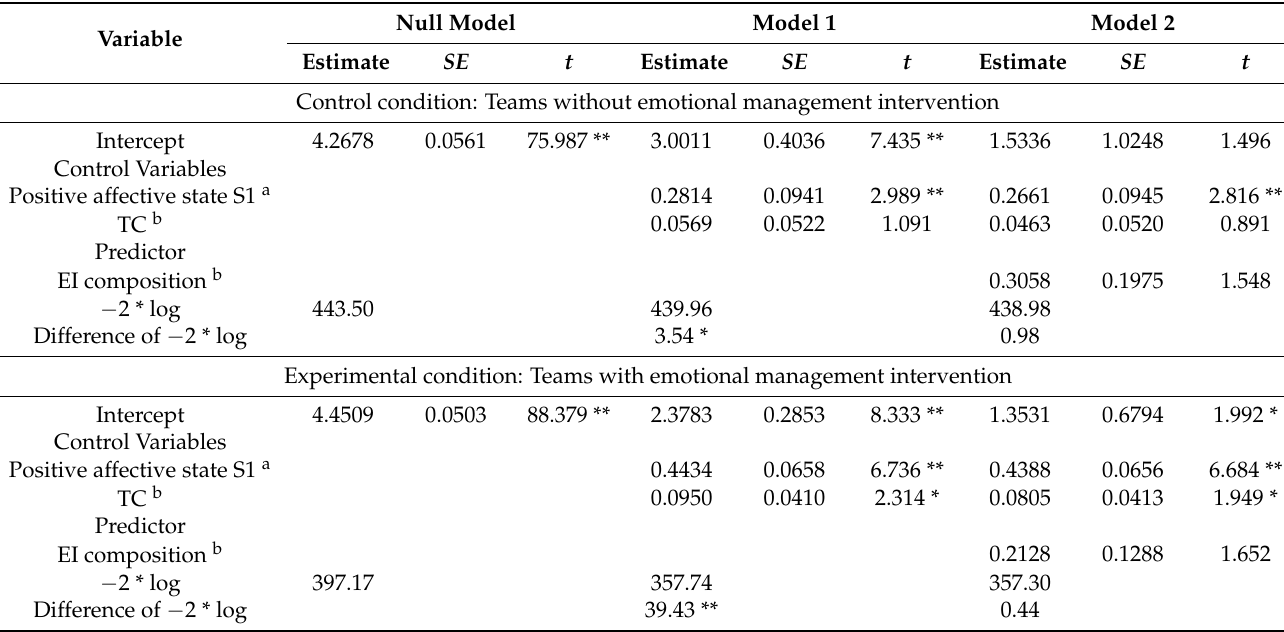
Table 4. Multilevel estimates for models predicting positive affective states in Session